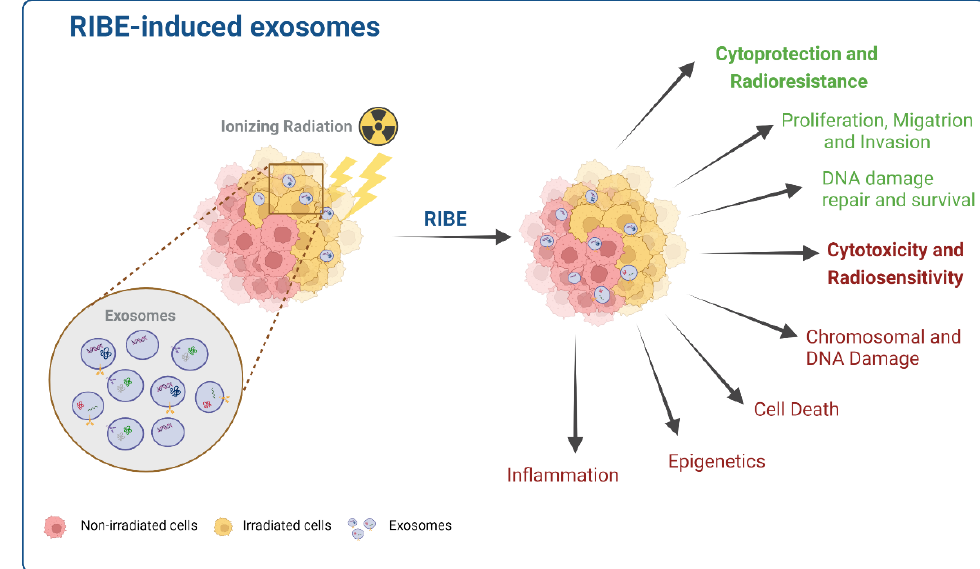
Figure 3. Exosomes-induced RIBE in recipient cells enhances the mechanism associated with cytopro- tecting and cancer radioresistance (green) or, on the opposite, the mechanism associated with cancer radiosensitivity and cytotoxicity (red). Created with